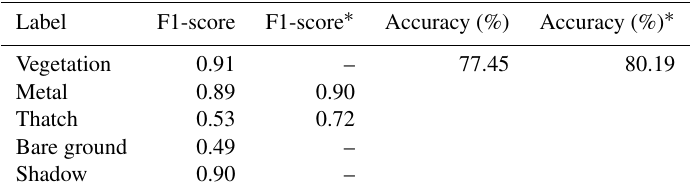
Figure 9. Constructed damage curves for the two types derived from field and aerial observations for the object-based approach (a) , and three types derived from the description of building stock at district level for the pixel-based approach (b) (Malawi National Statistical Office, 2017). The water depth is the flood water relative to the ground floor. Table 6. Evaluation of the performance accuracy of the OBIA classification.